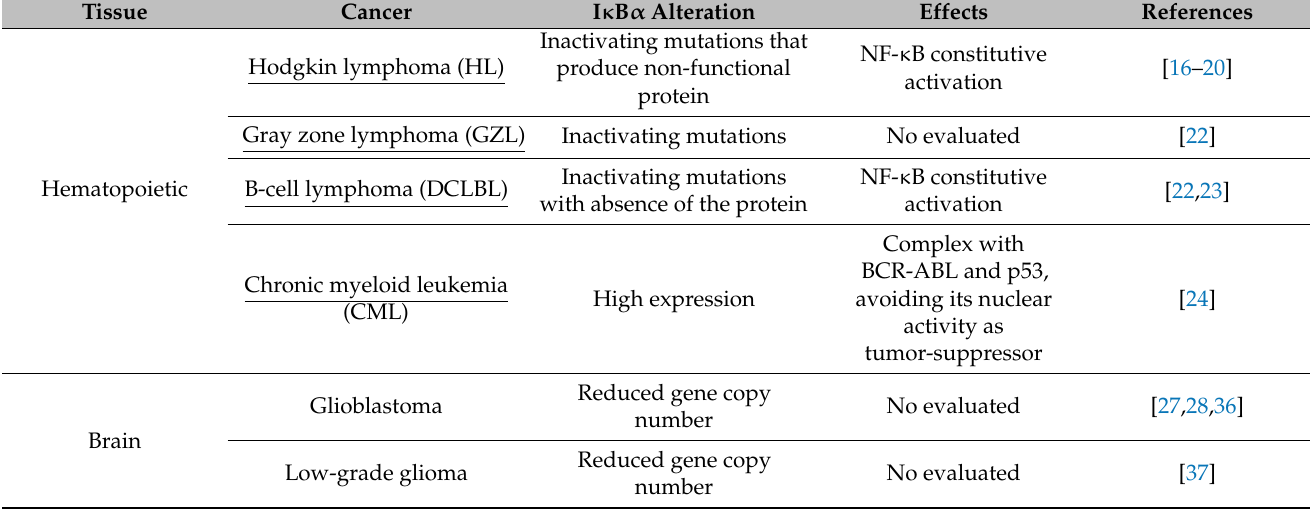
Table 1. Table representing the alterations of NFKBI gene and/or I κ B α activity associated with different types of human cancer and murine cancer